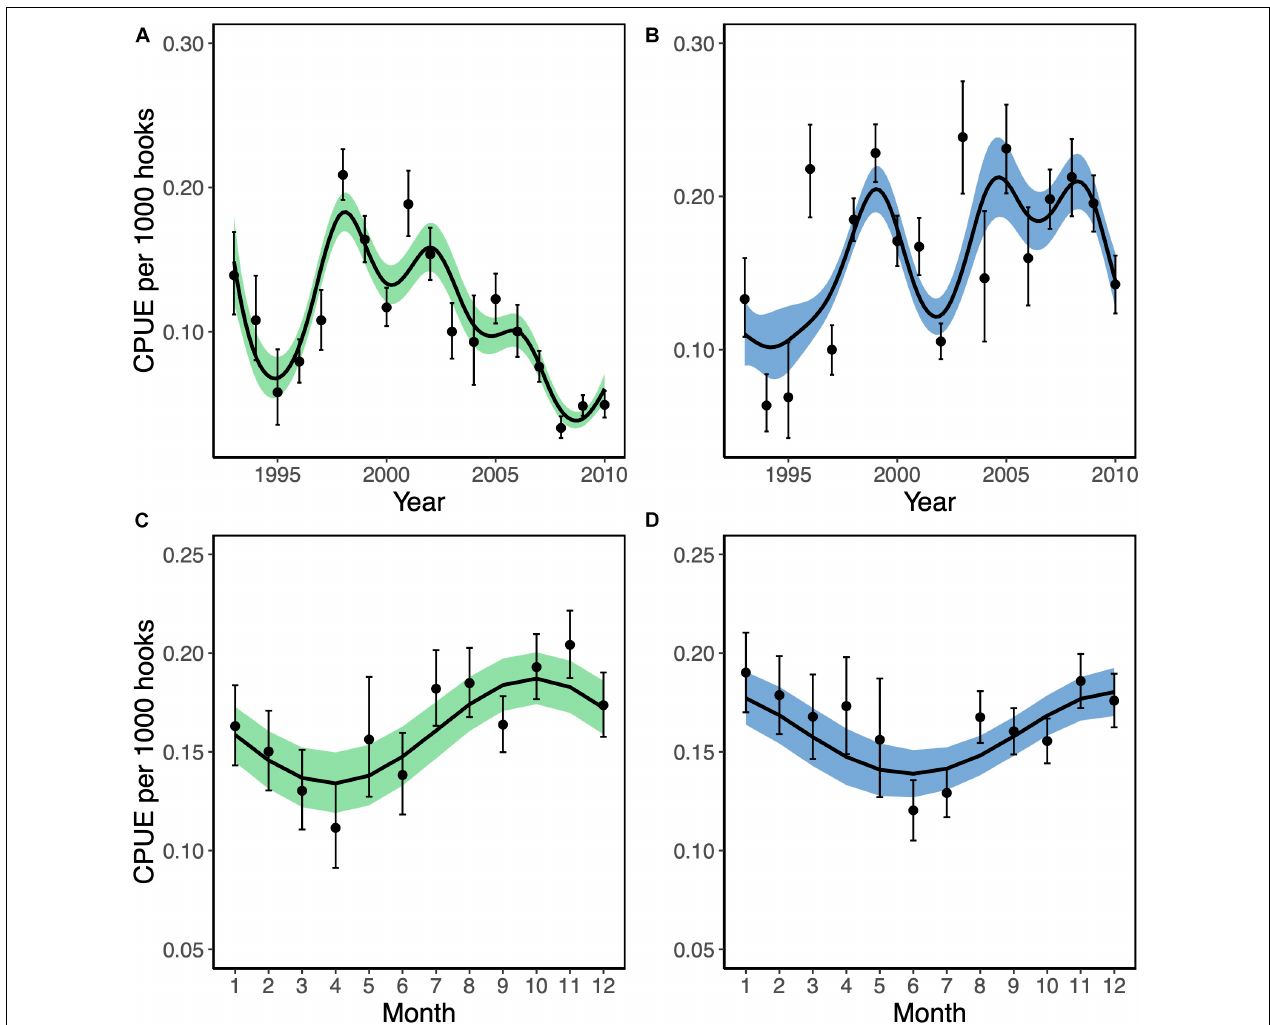
FIGURE 2 | Standardized trends in catch per unit effort (CPUE; tons per thousand hooks) of yellowfin ( Thunnus albacares ; green) and bigeye tuna ( Thunnus obesus ; blue) from longline vessels in the British Indian Ocean Territory between 1993 and 2010. Trend lines represent the predicted CPUE from averaged generalized additive mixed models with year (A,C) and month (B,D) as continuous response variables. Points indicate CPUE estimates from models with the temporal response variable as factors. Shaded polygons and error bars represent ± two standard